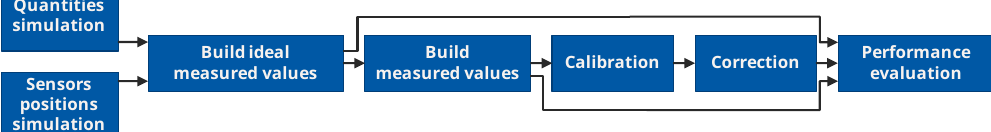
Figure 2. Schematic diagram of the methodology proposed for in situ calibration strategies